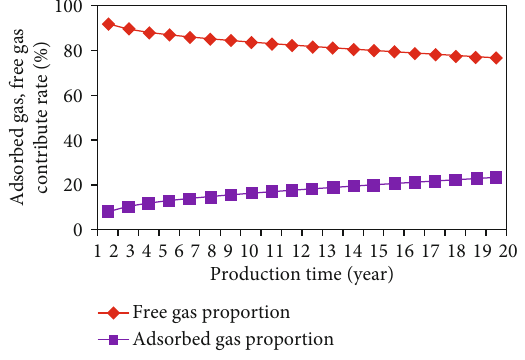
Figure 5: Adsorbed gas and free gas contribution rate versus production